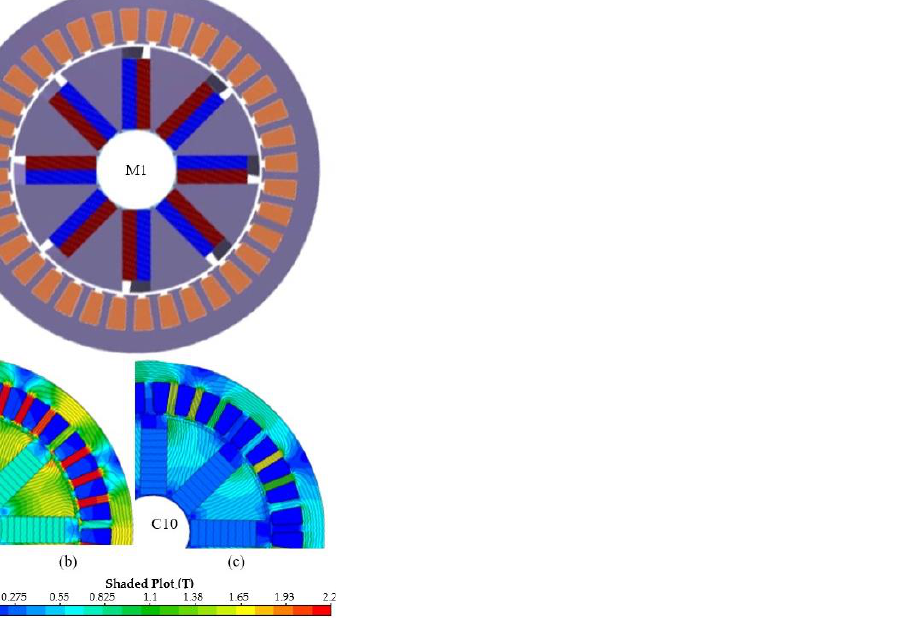
Figure 1. Tangential machine: ( a ) general view, ( b ) magnetic flux density in the stator and rotor core of N42 PM machine, ( c ) magnetic flux density distribution in the stator and rotor core of C10 PM machines.